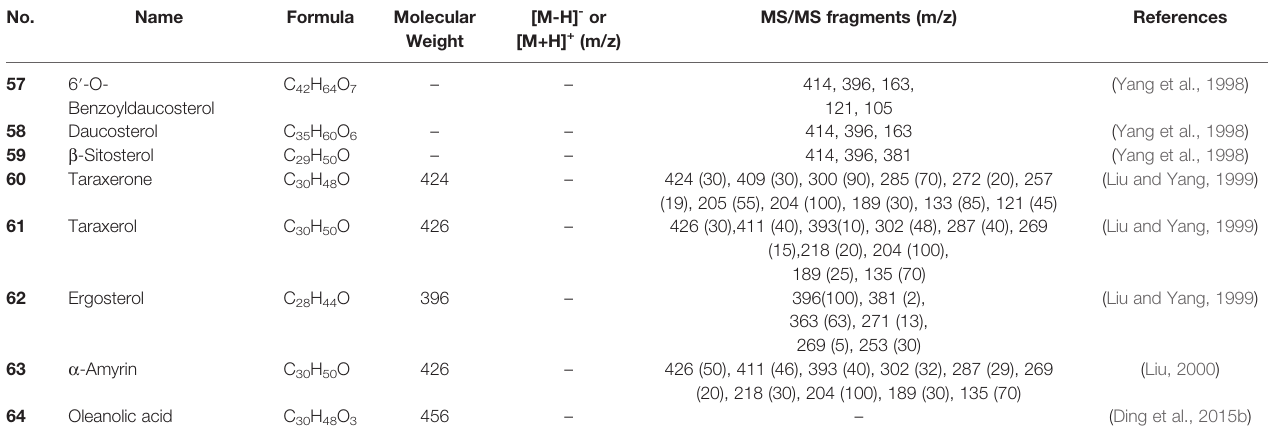
TABLE 3 | Triterpenoids and steroids isolated from Tetrastigma hemsleyanum Diels & Gilg.